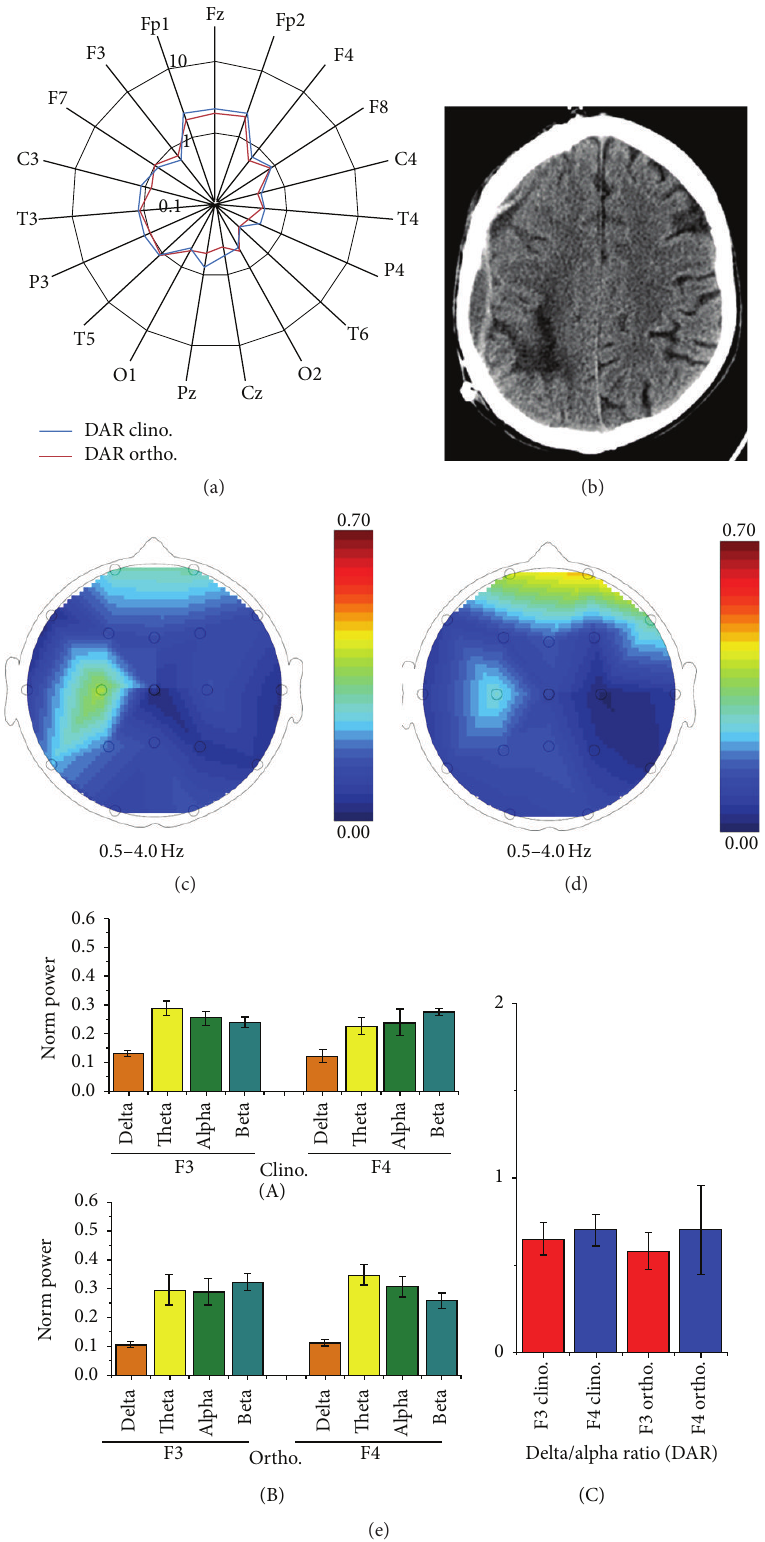
Figure 2: Postcranioplasty findings. DAR value for each electrode in clino- and orthostatic positions, shown on a logarithmic scale (a). Brain CT scan showing the posthemorrhagic lesion and cranioplasty results (b). Delta power band distribution maps in clino- (c) and orthostatic (d) positions. Mean normalized band powers of F3 and F4 signals in clino- ((e)(A)) and orthostatic ((e)(B)) positions. DAR in F3 and F4 in both positions